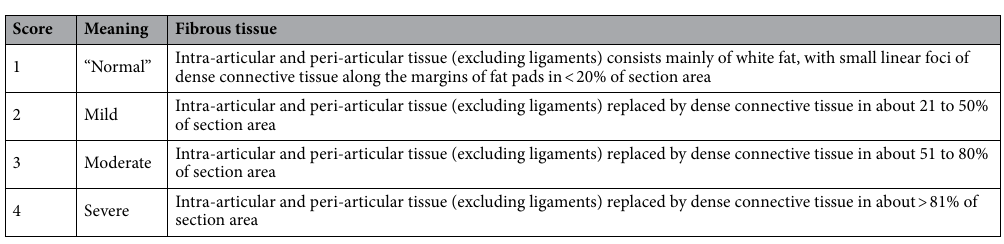
Table 2. Semi-quantitative histopathologic scoring criteria for the fibrous tissue on H&E stains.